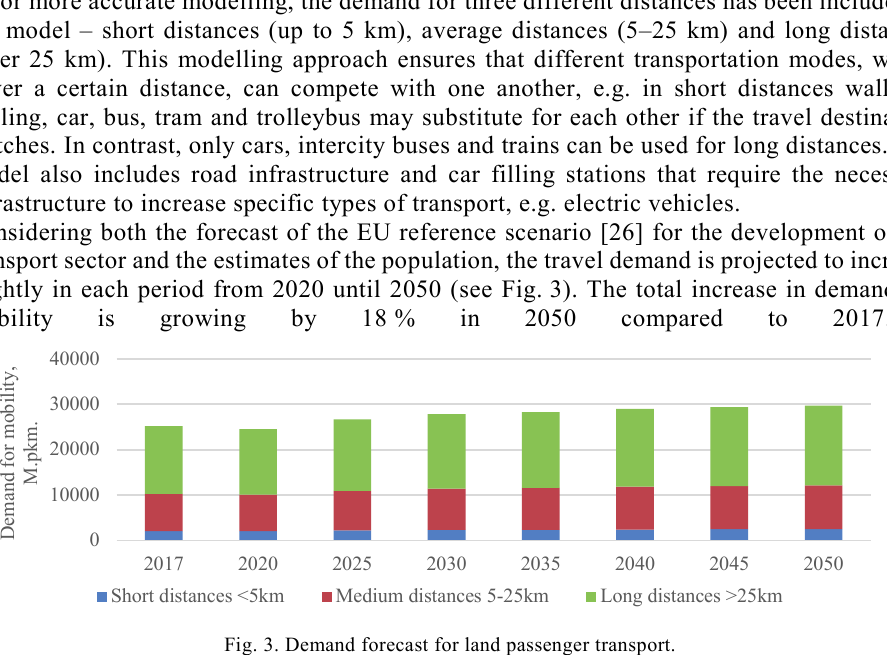
Fig. 3. Demand forecast for land passenger